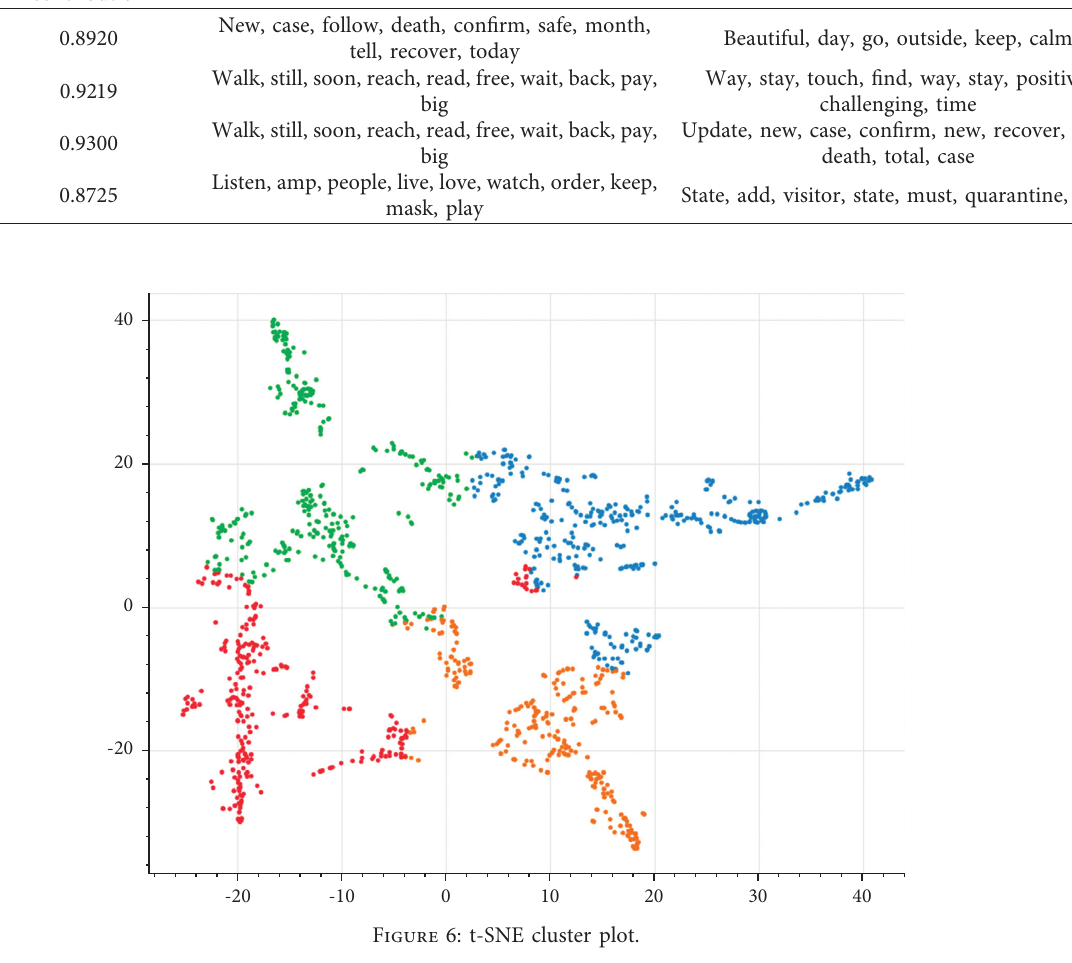
Figure 3. Researchers prefer LDA method for finding topics